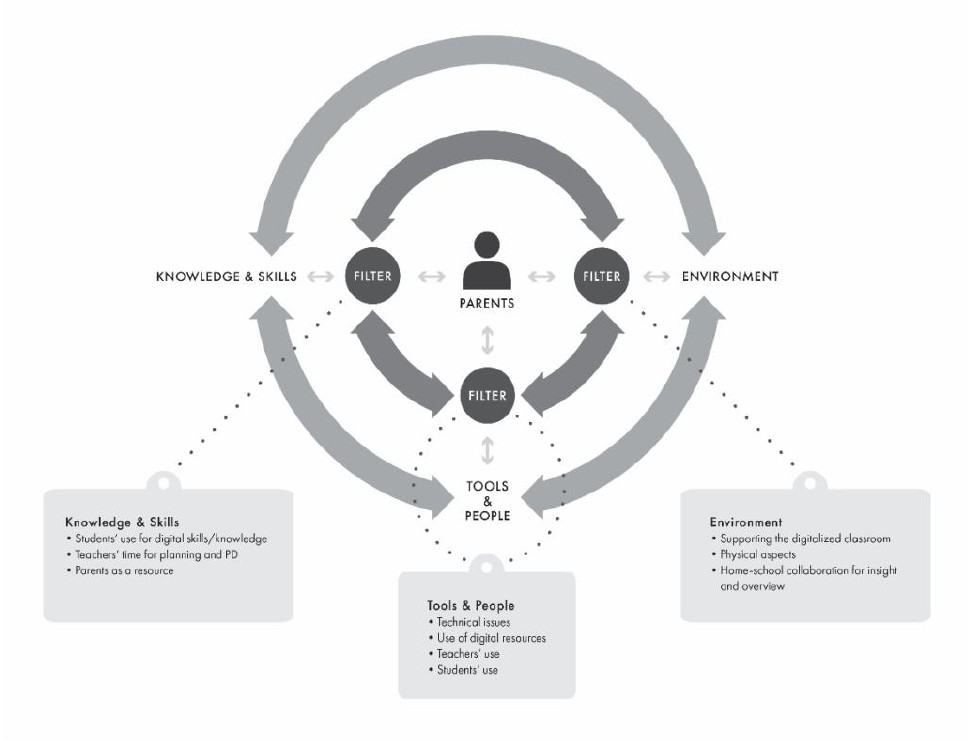
Figure 2 Challenges and opportunities from the parent perspective using the Ecology of Resources model (Luckin,